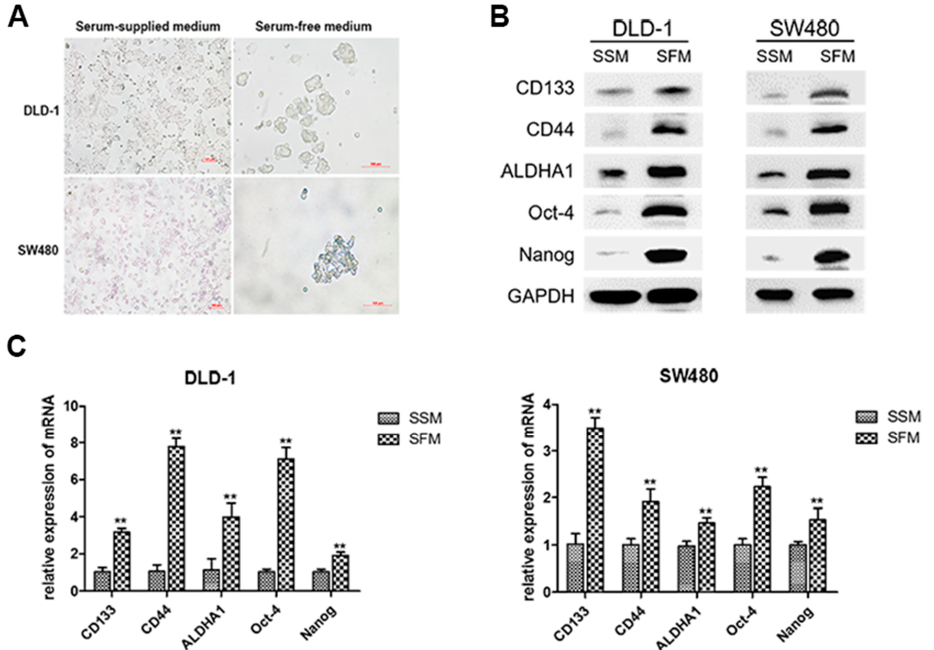
Figure 2. Enrichment of colorectal CSCs by serum-free-medium culture. DLD-1 and SW480 cells were cultured in serum-supplied medium (SSM) and serum-free medium (SFM) for six days. ( A ) Cell morphology was imaged under a light microscope. ( B ) The protein levels of CSC markers, including CD133, CD44, ALDHA1, Nanog, and Oct4, were measured by Western blotting analysis. ( C ) The mRNA levels of corresponding CSC markers were examined by Quantitative real-time PCR. Data are expressed as mean ± SD of three independent experiments. ** p < 0.01 compared with control group.